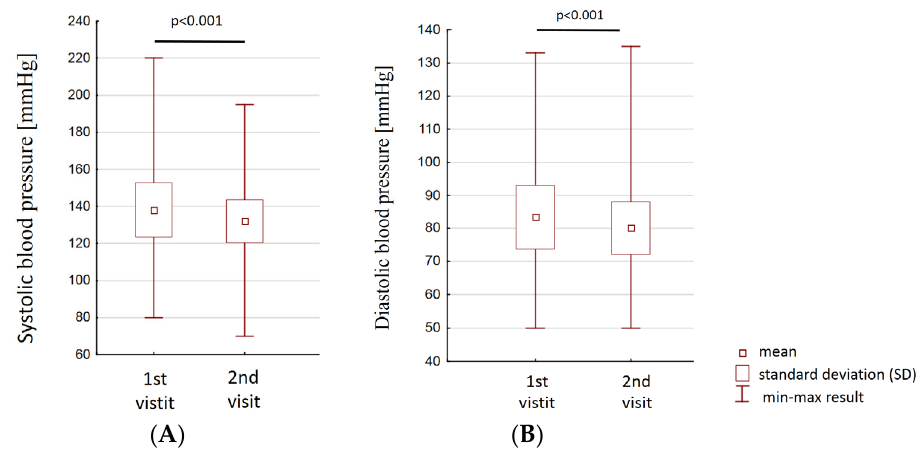
Figure 8. Comparison of blood pressure ( A )—systolic; ( B )—diastolic between the first and second vistits.